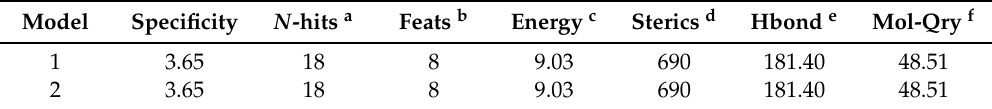
Table 1. Results of the pharmacophore hypothesis generated using the Galahad module.